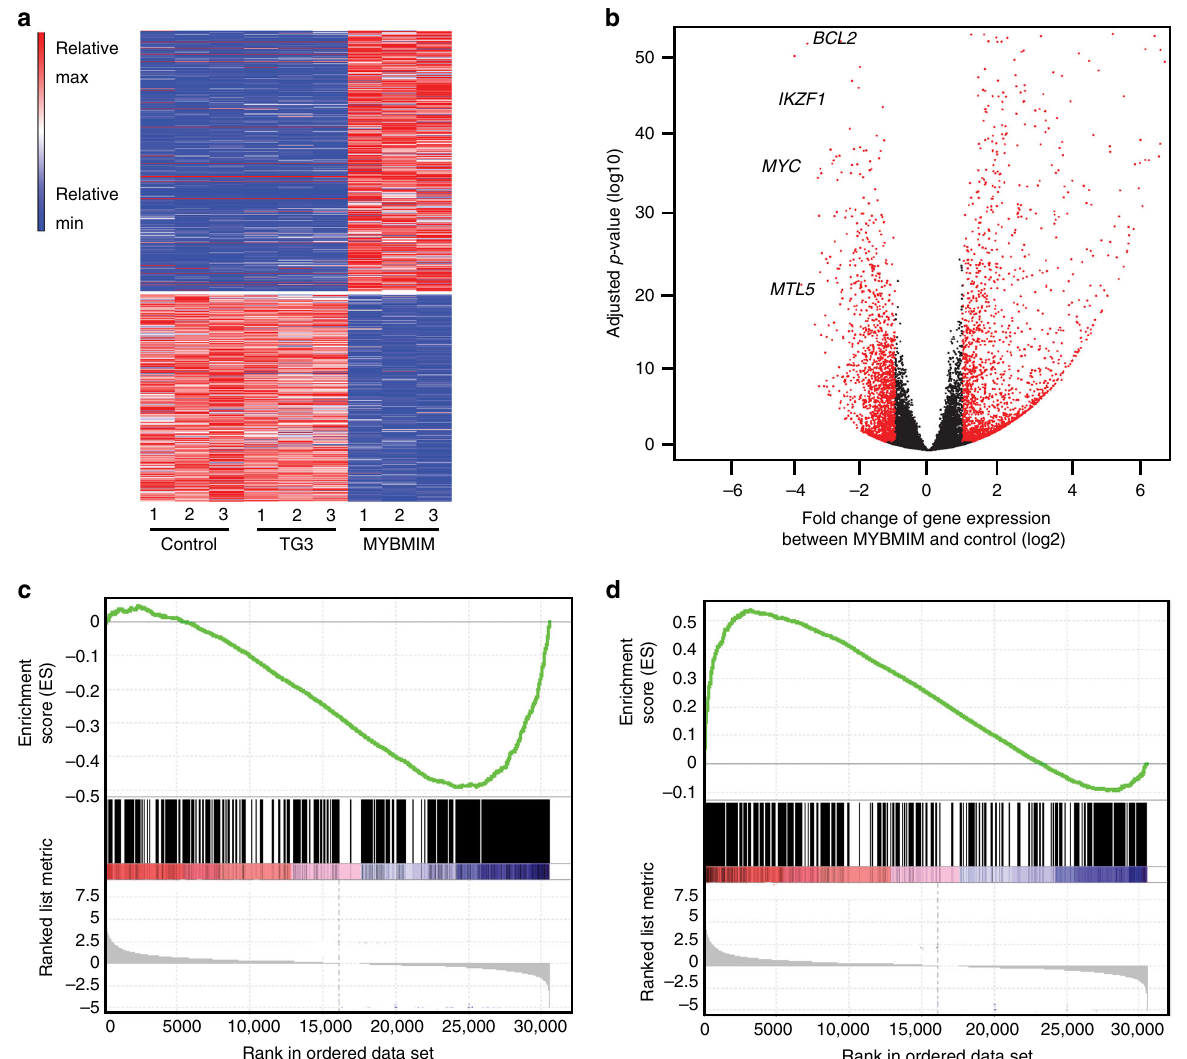
Fig. 2 MYBMIM regulates MYB enhancers and promoters and MYB-dependent target genes. a Heatmap of changes in normalized gene expression of MOLM13 cells treated with 20 µ M MYBMIM versus TG3 control for 6 h, as analyzed by RNA-seq of three biological replicates. b Volcano plot of normalized gene expression, with BCL2, IKZF1, MYC and MTL5 as indicated. c , d Gene set enrichment analysis of downregulated c and upregulated d genes with respect to MYB target genes, as de fi ned by 8 . NES = − 2.47 and 2.09, and q = 0 and 0,